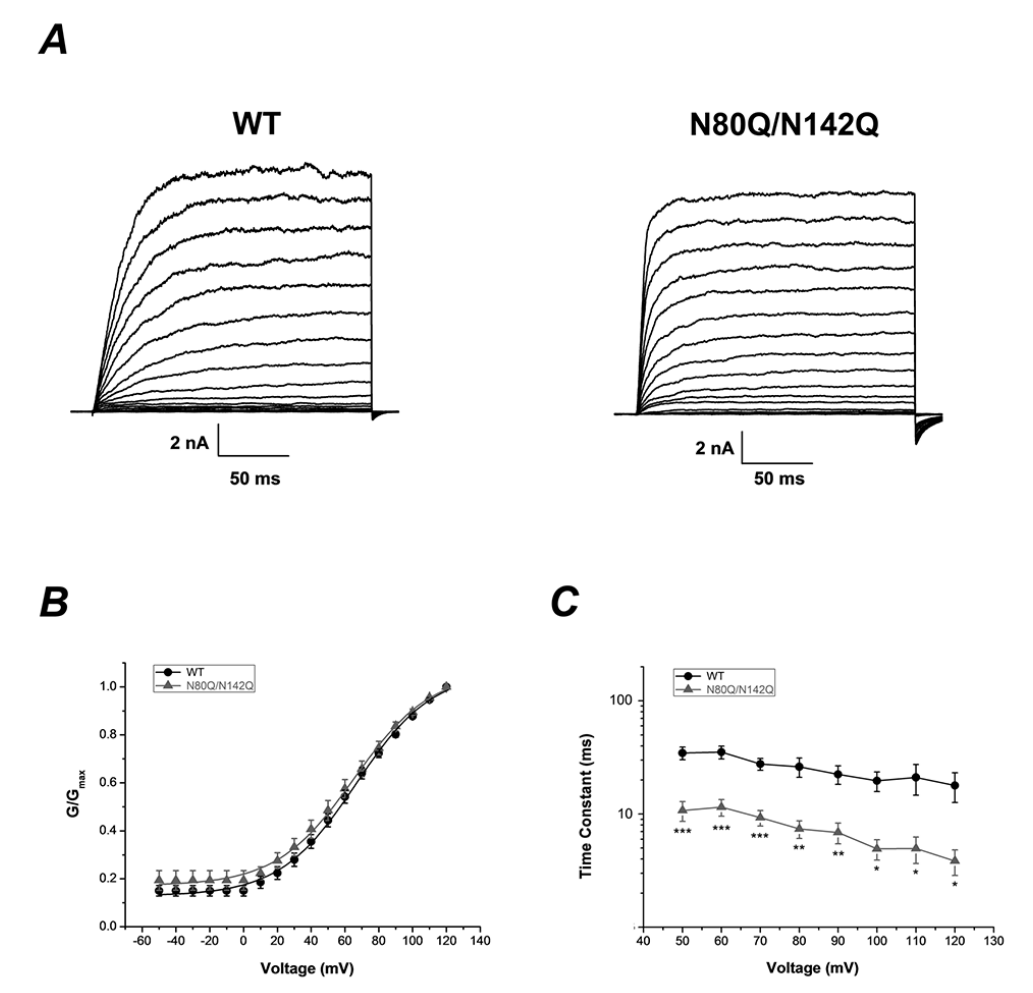
Figure 5. Deglycosylation of β 1 subunit did not shift steady-state activation of BK channels ( α + β 1). (A) Representative whole cell current traces from HEK 293T cells expressing wild type BK channels ( α + β 1) (left), N80Q/N142Q (right). The channels were stepped from -50 mV to +120 mV in 10 mV steps with the holding potential at -80 mV. (B) The plots of the normalized conductance fit well with Boltzmann function. The voltage-dependent activation curves were insignificantly shifted before and after the deglycosylation. (C) Time constants are shown for wild-type BK channels ( α + β 1) (n = 5, black circle), N80Q/N142Q (n = 7, gray circle).